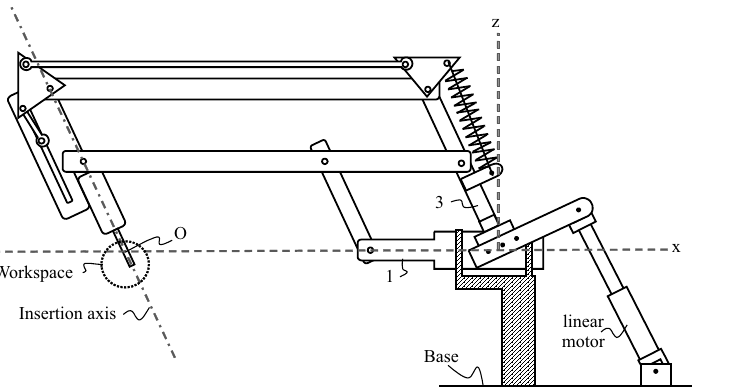
Figure 3. Candidate architecture in tilted position, where the numbers represent the names of the rods, and the letters the names of the rotation axes.